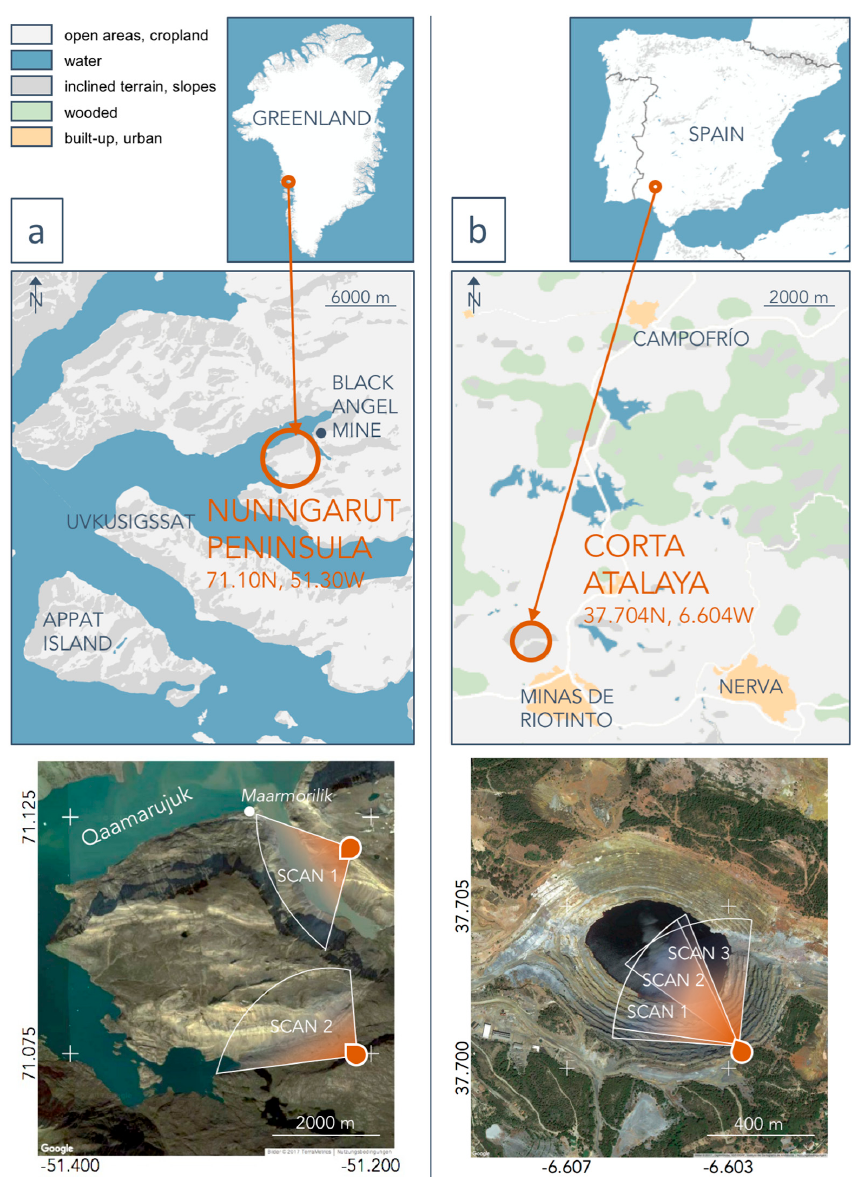
Figure 1. Location of the two investigated sites and schematic coverage of the acquired AisaFENIX hyperspectral imagery at: ( a ) Nunngarut Peninsula, Maarmorilik, Greenland; and ( b ) Corta Atalaya open pit, Minas de Rio Tinto, Spain. open pit, Minas de Rio Tinto,